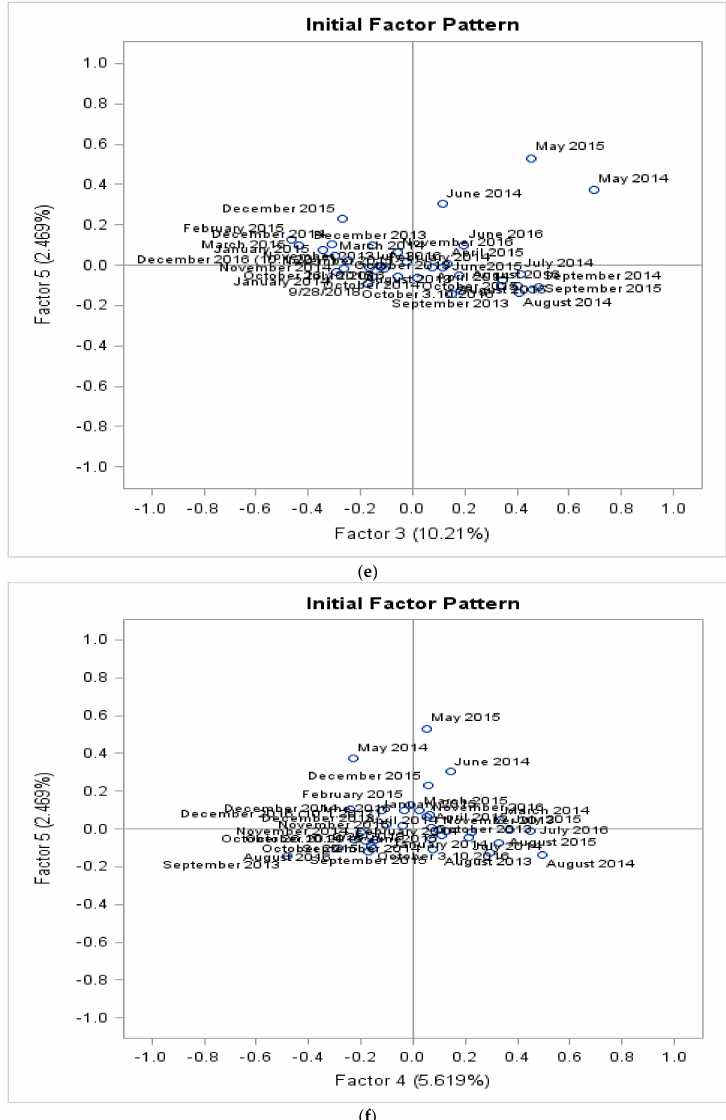
Figure 18. Six score plots built for five factor combinations at the Liito-oravankatu site. ( a ) Factor 4 vs. Factor 2. ( b ) Factor 4 vs. Factor 3. ( c ) Factor 5 vs. Factor 1. ( d ) Factor 5 vs. Factor 2. ( e ) Factor 5 vs. Factor 3. ( f ) Factor 5 vs. Factor 4.4.